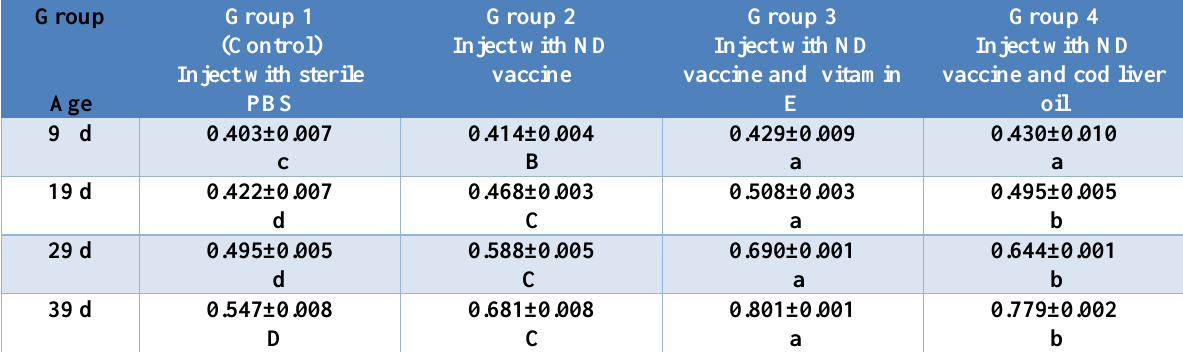
Table, 3: Mean ± standard error in mean of antibody titers against Newcastle Disease Virus measured by ELISA (Optical Density Value) for different